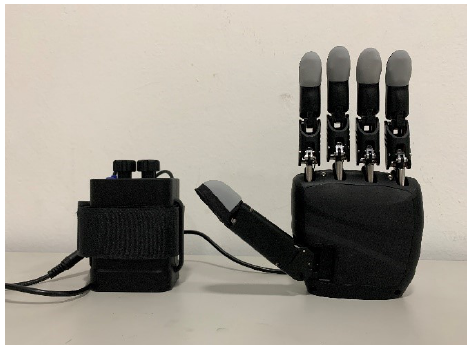
Figure 2. Linksense